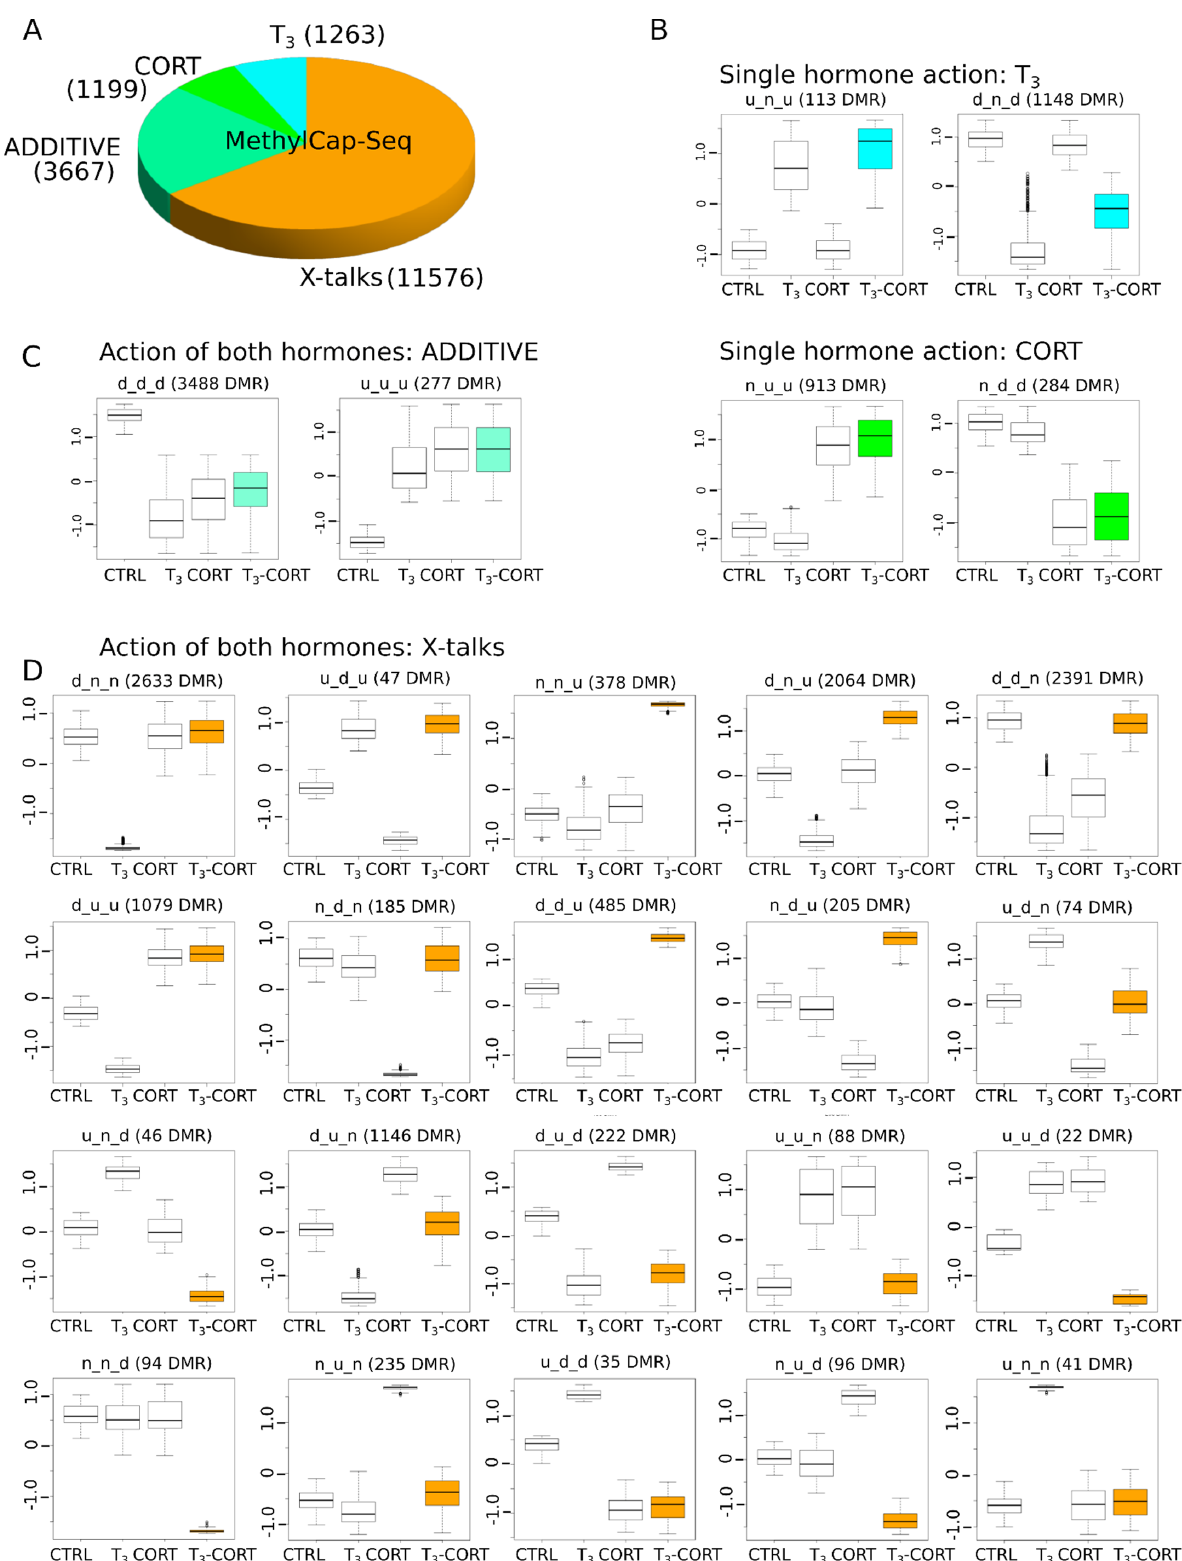
Figure 6. The complex dynamics of DNA methylation levels at DMRs. ( A ) Types of gene regulation by T 3 and CORT. ( B ) Gene regulation by either T 3 or CORT. ( C ) Gene regulation by T 3 and CORT. ( D ) Complex regulation by both hormones